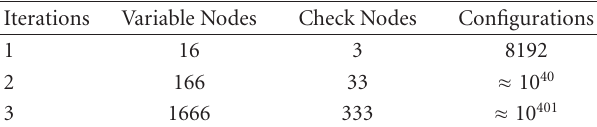
Table 1: The number of nodes and valid configurations on the computation tree of a (3,6)-regular LDPC